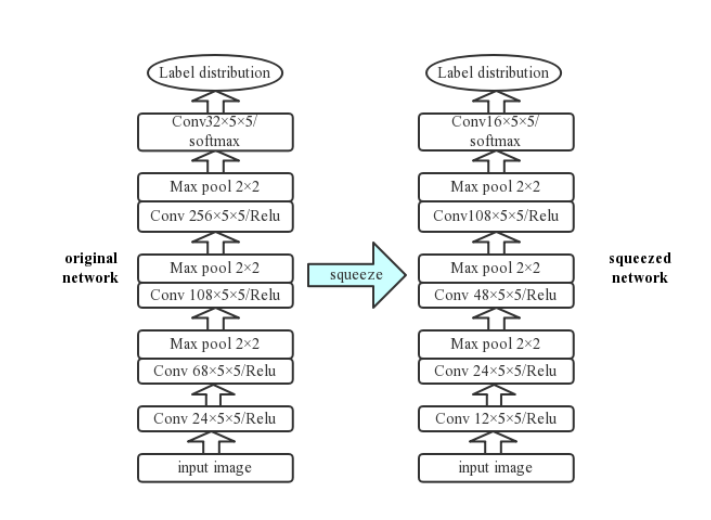
Figure 9. Illustration of original network and squeezed network.